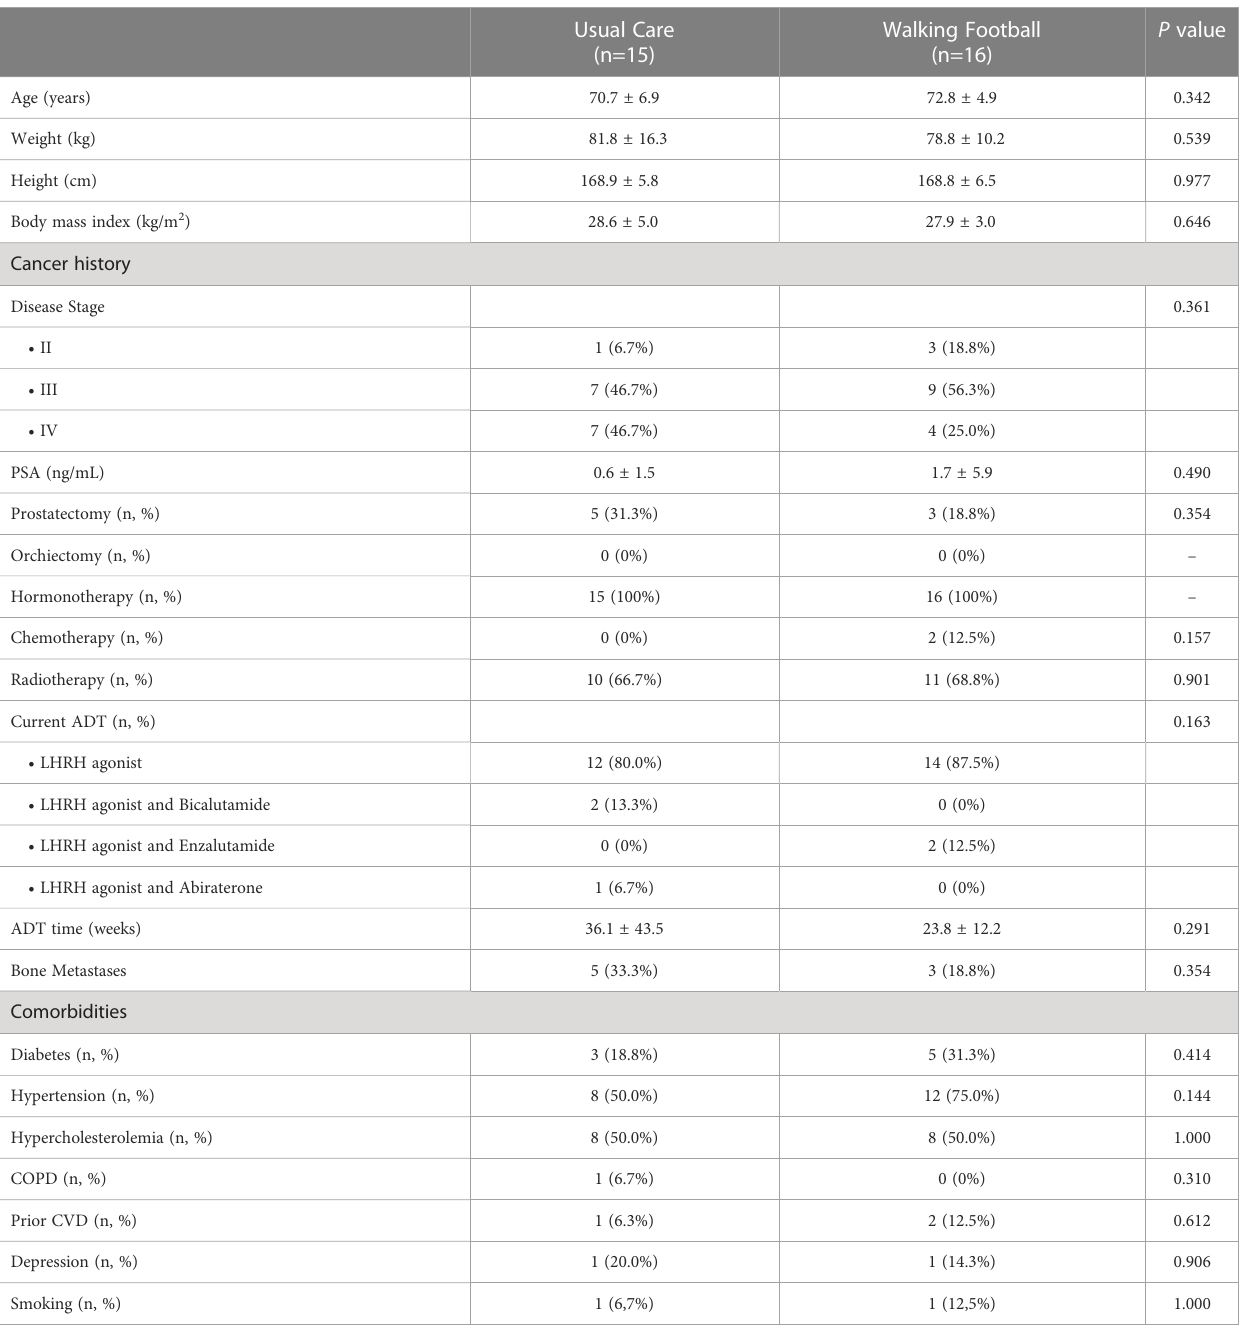
TABLE 1 Patient baseline